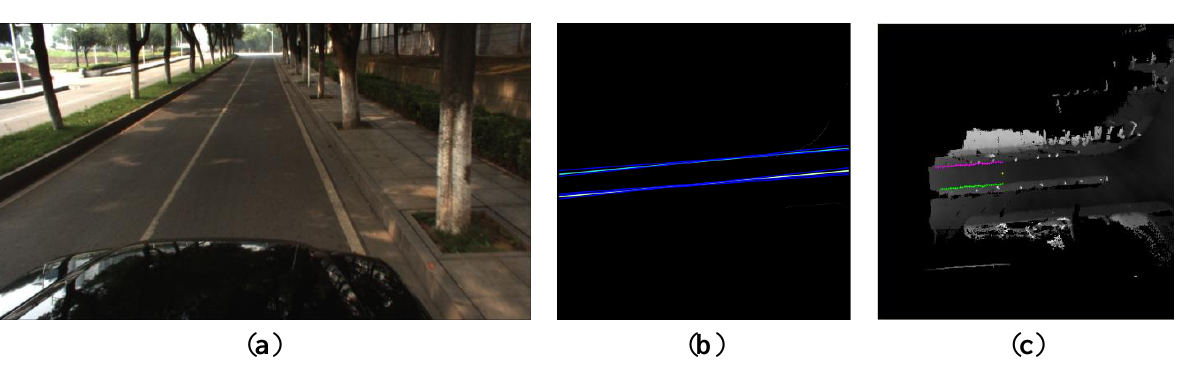
Figure 11. The result of the straight curb detection. ( a ) Scene 1. ( b ) The results of Hough transform. ( c ) The final curb detection results in the local DEM.